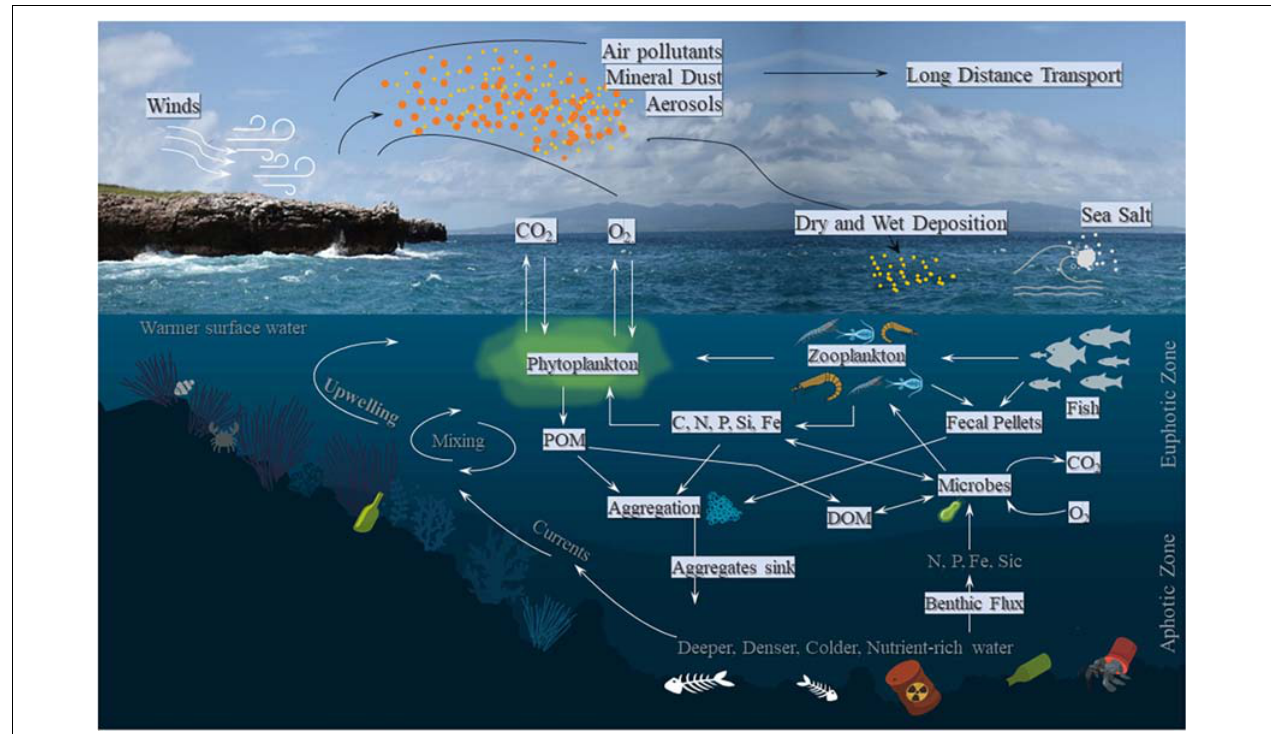
FIGURE 18 | Schematic diagram showing various physical and biogeochemical processes governing the oceanic phytoplankton biomass. The transport and deposition of aerosol and dust on the sea surface and its influence on the biogeochemical processes in the ocean are also